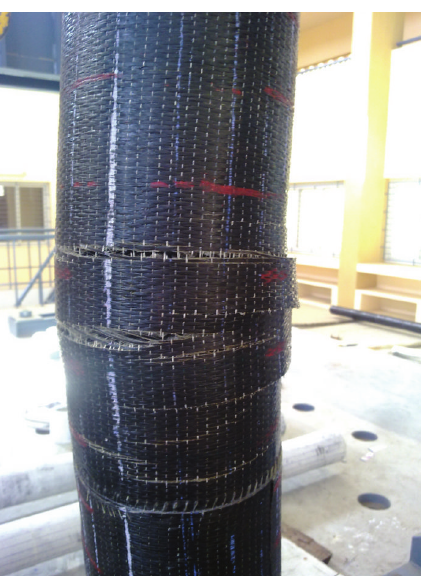
Figure 1: Orientation of fibre for compression warp in horizontal direction.